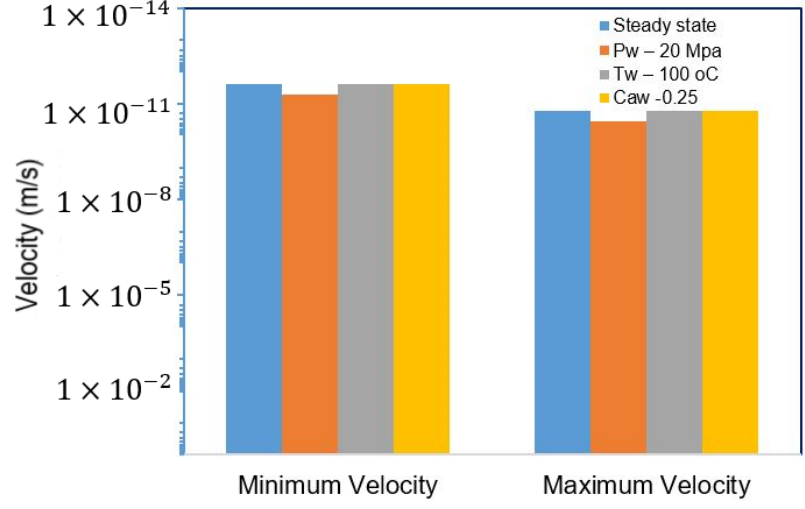
Figure 18. CSMP++ 3D vertical wellbore chemo-thermo-poroelasticity simulation.